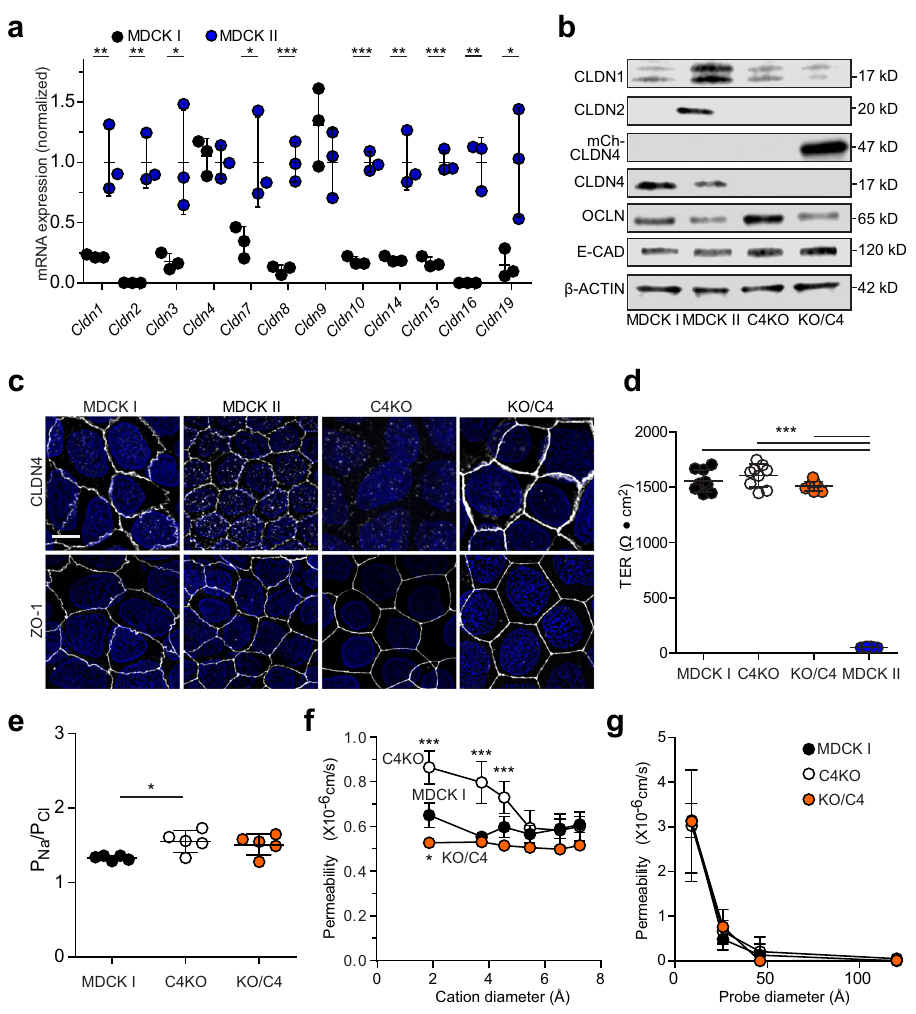
Fig. 1 Claudin-4 is not essential for tight junction barrier function. a Claudin isoform expression. MDCK I mRNA expression (black symbols) normalized to MDCK II (blue symbols) for each claudin. Some barrier-forming claudins are expressed in both MDCK I and MDCK II, while other barrier-forming and most pore-forming claudins are either absent or expressed at much lower levels in low conductance MDCK I cells. n = 3 independent samples. Two-tailed unpaired t -test comparisons between MDCK I and MDCK II. P( Cldn1 ) = 0.0082, P( Cldn2 ) = 0.0012, P( Cldn3 ) = 0.0311, P( Cldn7 ) = 0.0435, P( Cldn8 ) =